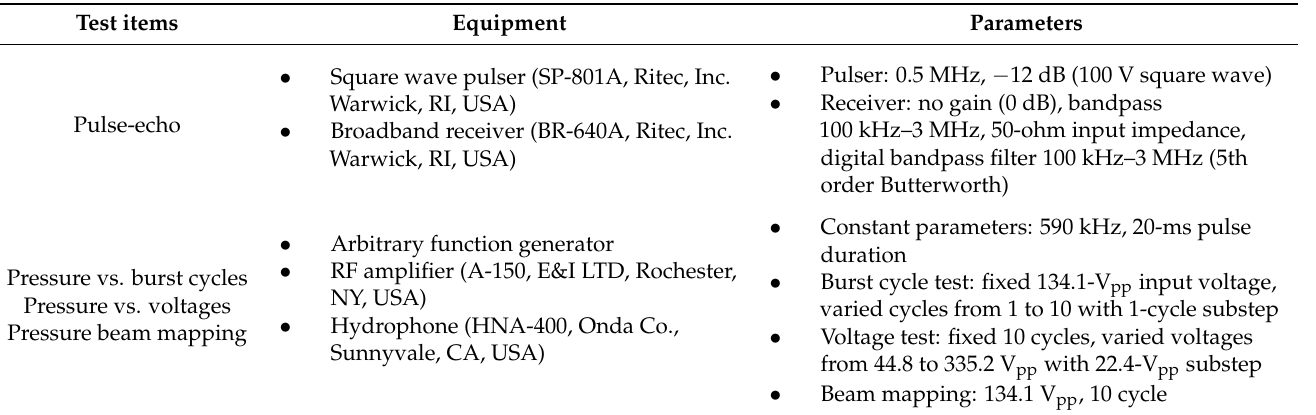
Table 2. Acoustic characterization setup and